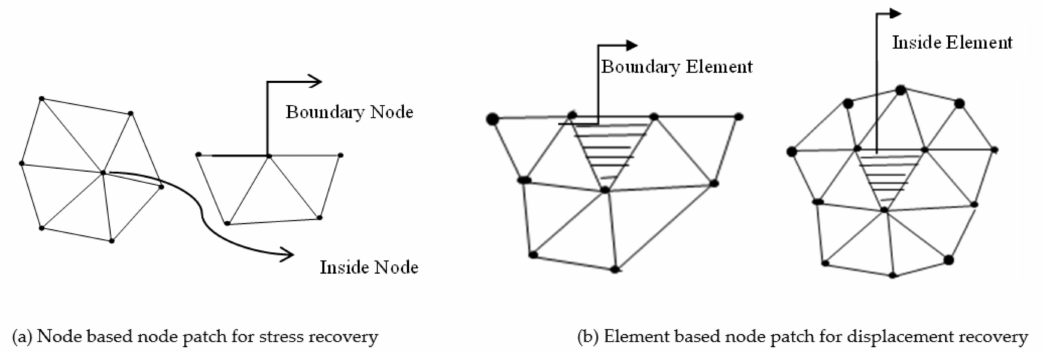
Figure 2. Node based Patches for stress error recovery and Element based Patches for displacement error recovery.